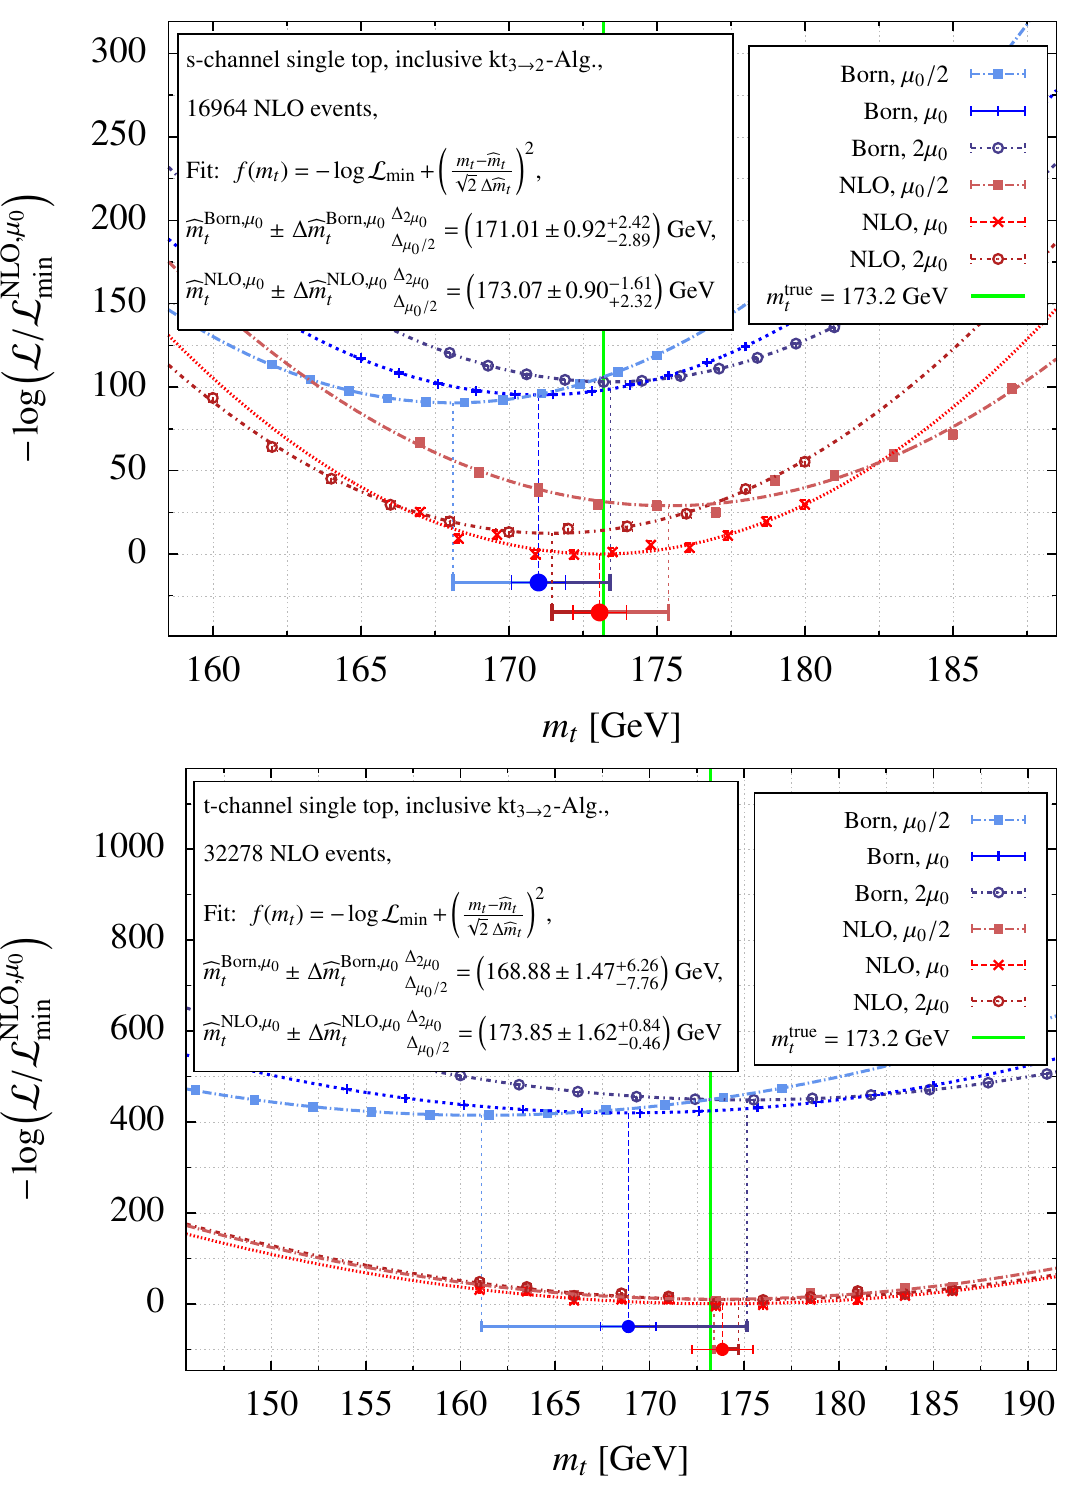
Figure 15 . Same as (cid:12)gure 13 but for the inclusive event de(cid:12)nition.